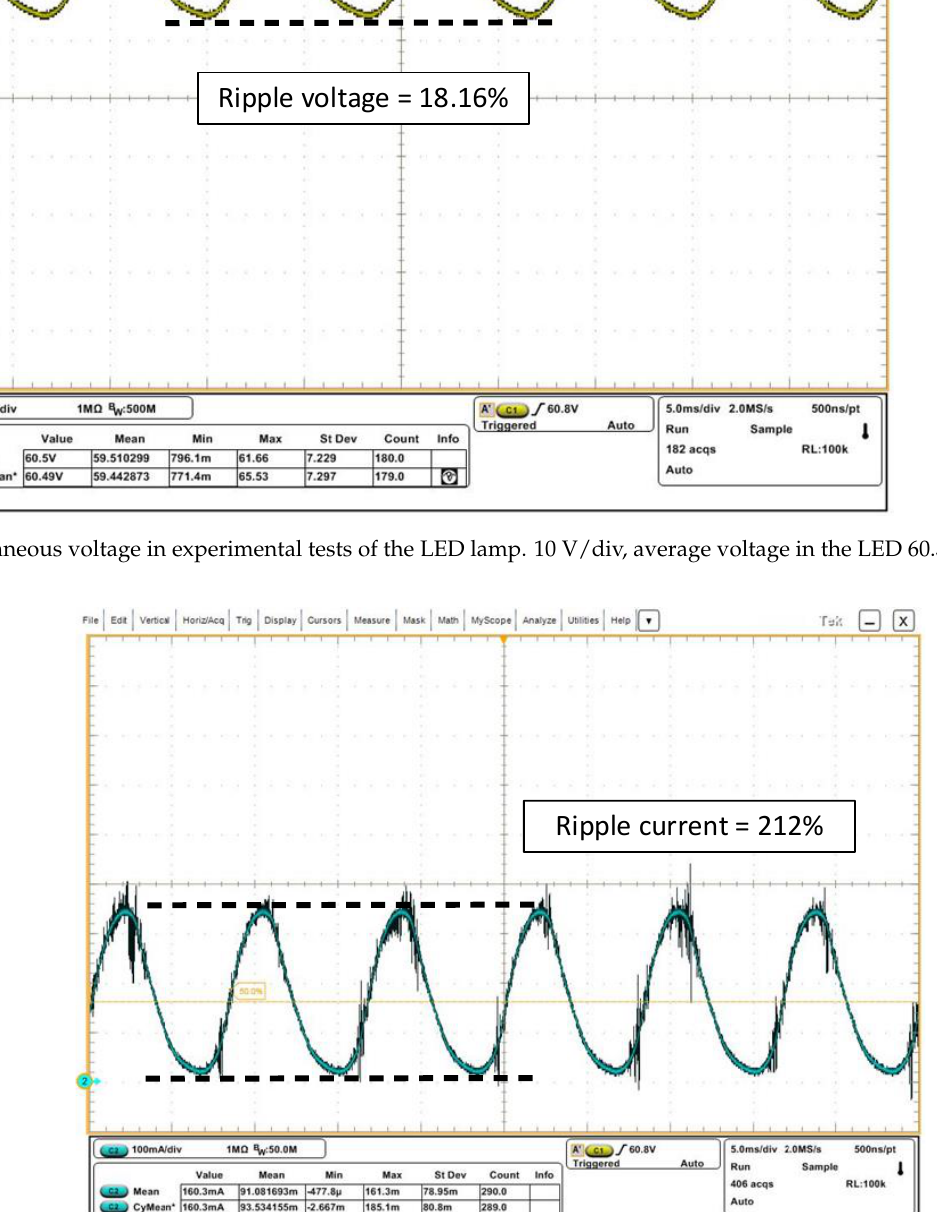
Figure 19. Instantaneous current in experimental tests of the LED lamp. 100 mA/div, average current in the LED 160.3 mA.